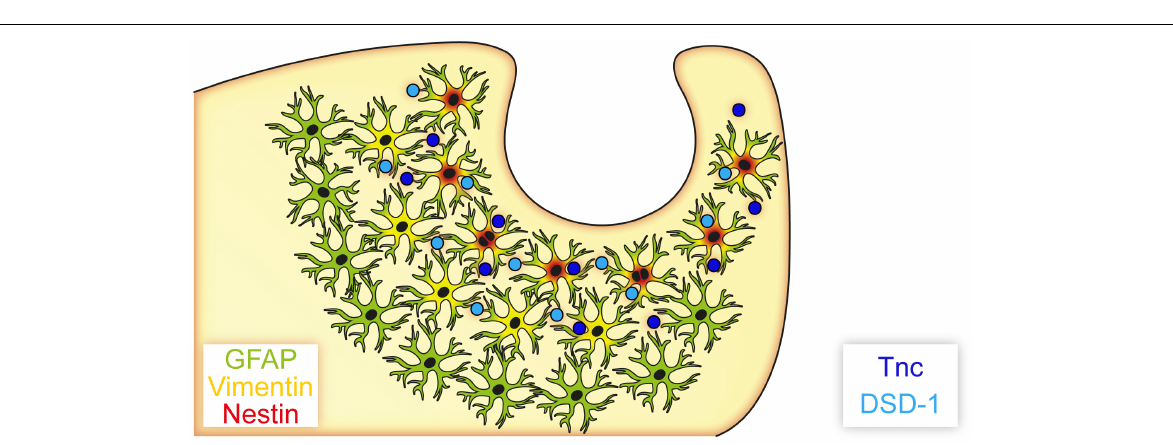
FIGURE 10 | Astrocyte subpopulations and extracellular matrix after cortical laser lesion. Reactive astrocytes with distinct marker profiles were observed in a region-specific manner. GFAP-positive cells were found in a broad region of the penumbra, whereas only subpopulations of these cells also coexpressed vimentin or nestin. These markers combined with an extracellular matrix containing neural stem/progenitor cell-associated factors like Tnc and the DSD-1 epitope indicate an immature cell fate of these astrocyte subpopulations, potentially facilitated by an environment resembling parts of the neural stem cell